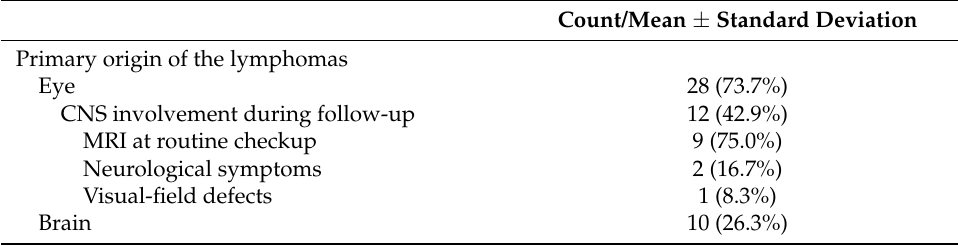
Table 3. Origin and involvement patterns of vitreoretinal